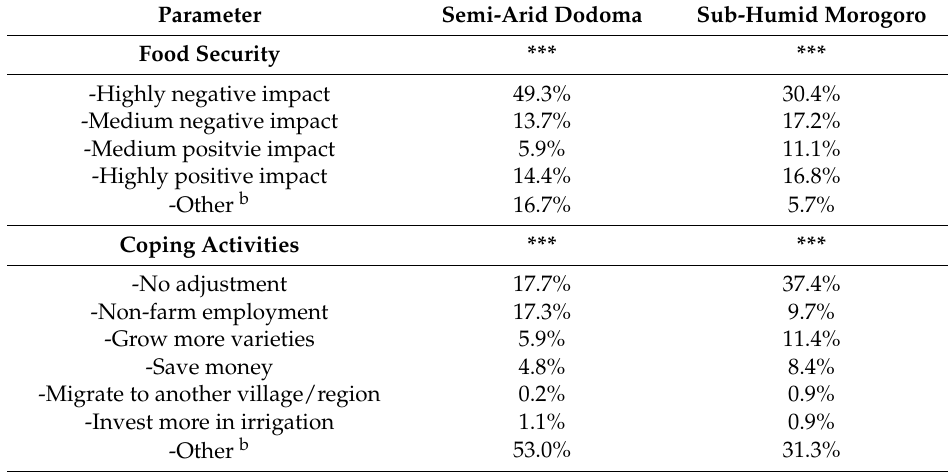
Table 3. Perceptions of impact on food security and utilized coping activities in Dodoma and Morogoro (Mann–Whitney-U